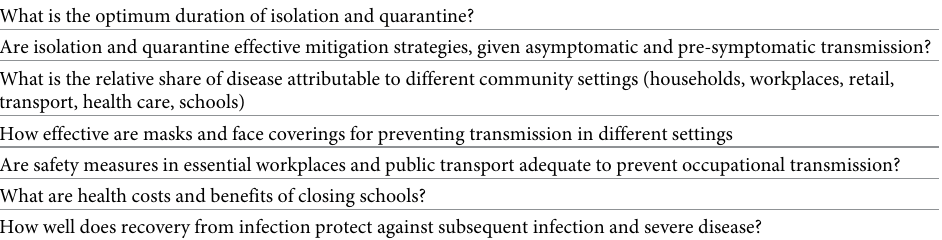
Table 5. Examples of research questions relevant to US COVID-19 policy